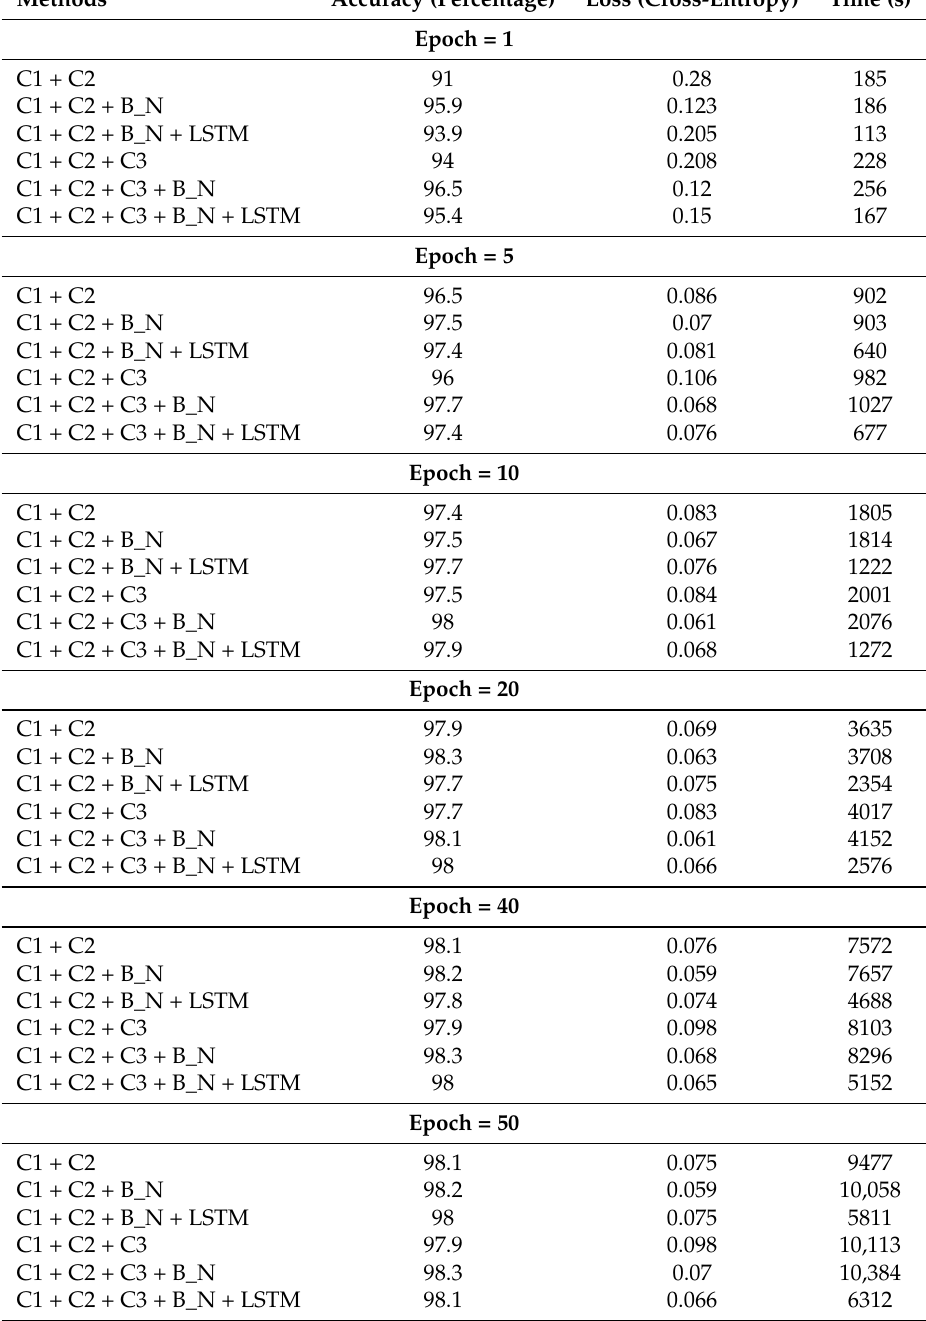
Table 5. Accuracy, loss and time for different numbers of epochs (20% sample) for the MNIST dataset.